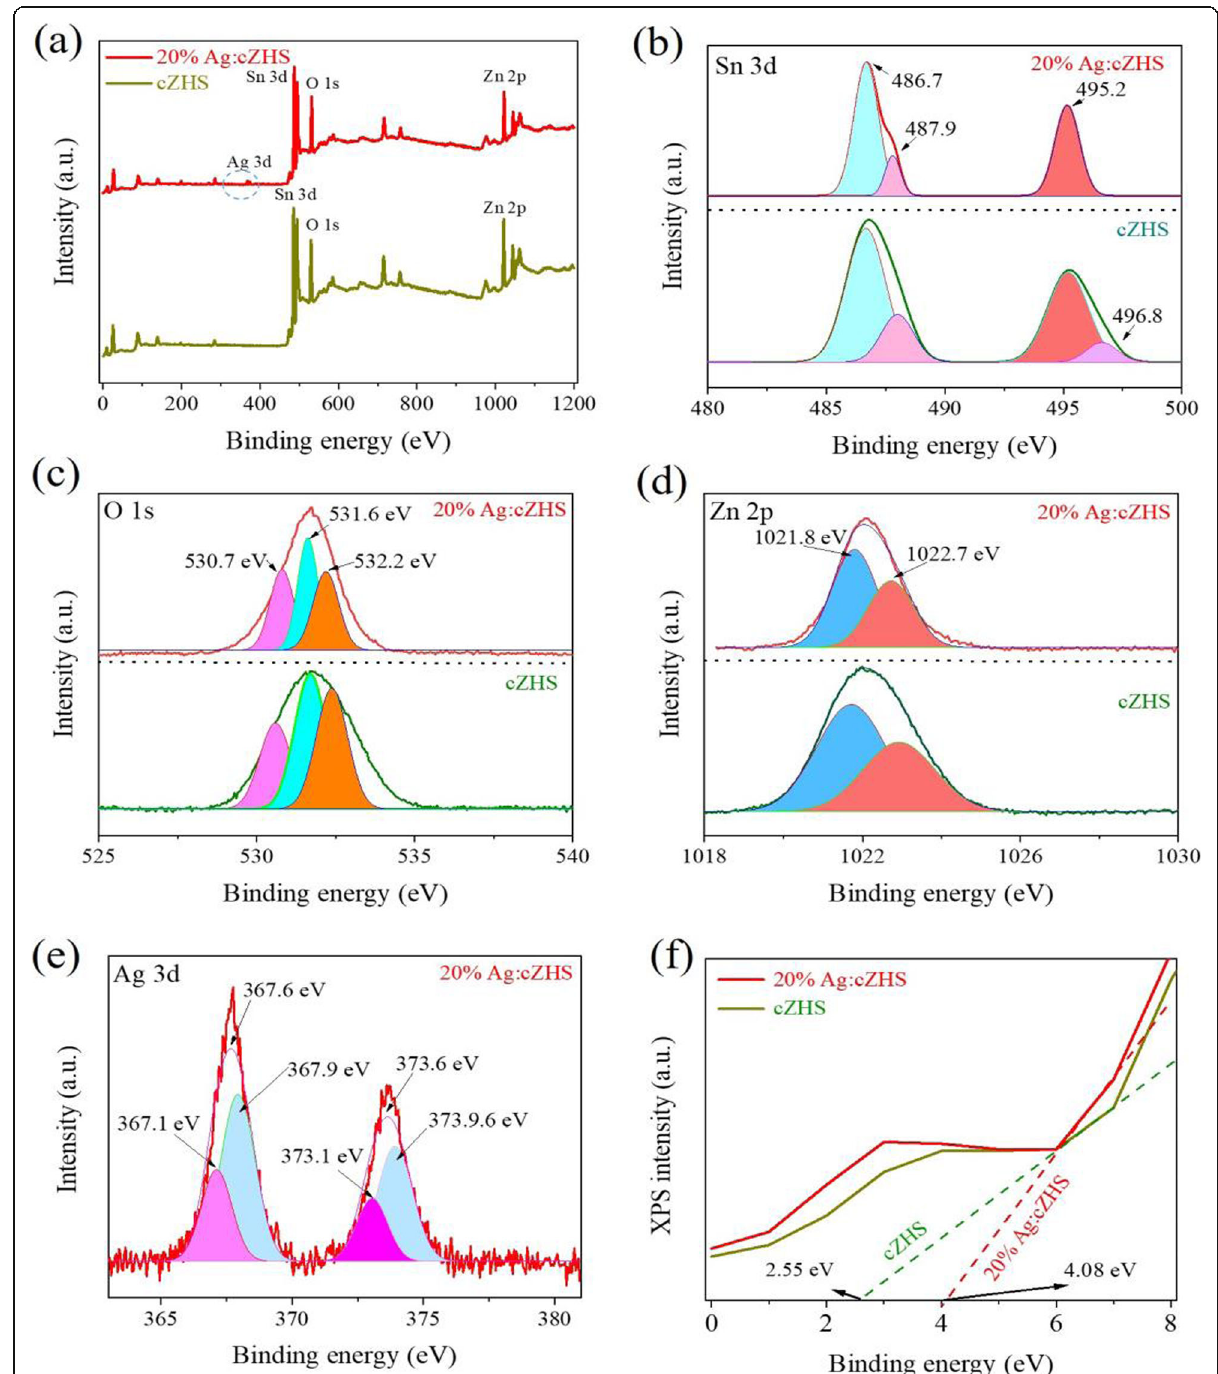
Fig. 8 XPS survey ( a ), high-resolution Sn 3d XPS ( b ), high-resolution O 1 s XPS ( c ), high-resolution Zn 2p XPS ( d ), high-resolution Ag 3d XPS ( e ), and valence band edge spectra ( f ) of cZHS and 20%